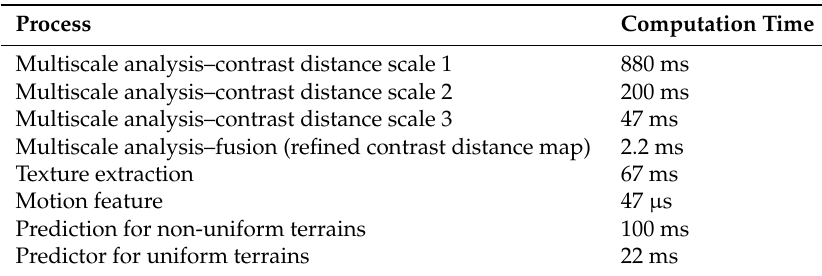
Table 4. Computation